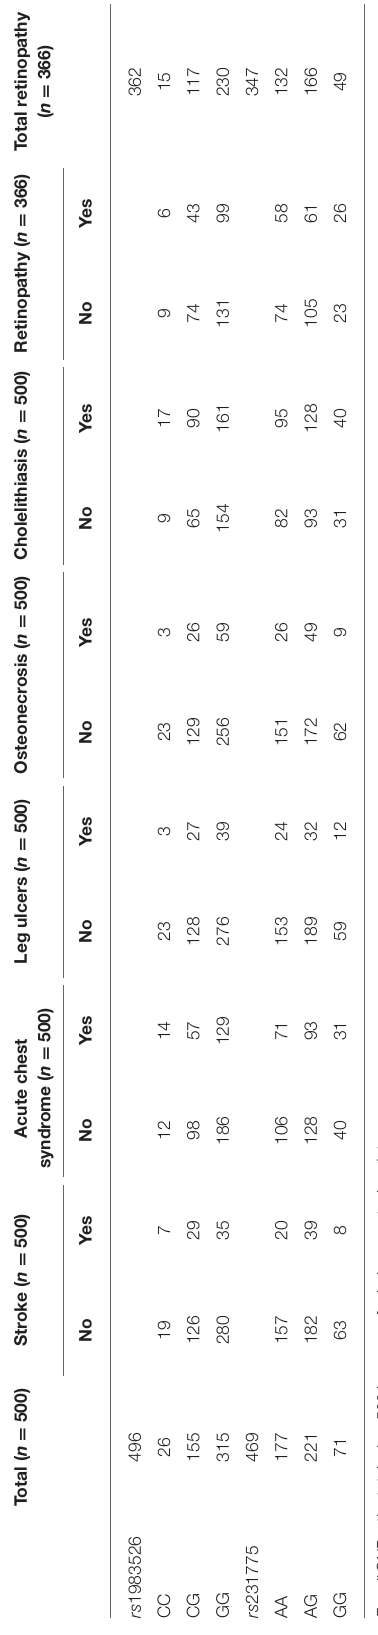
correspondence analysis. By mean of logistic regression models, we found no association between any of the SNPs in TLR genes and clinical complications. Table 3 summarizes the results of the logistic regression analyses.